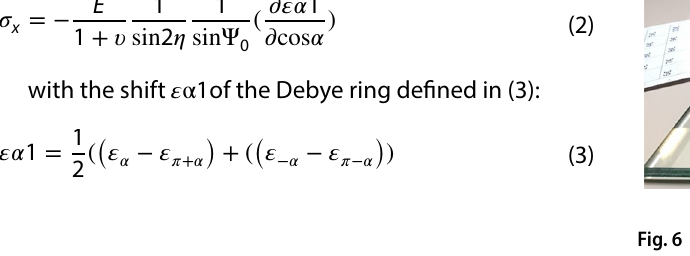
Fig. 6 A µ-X360s